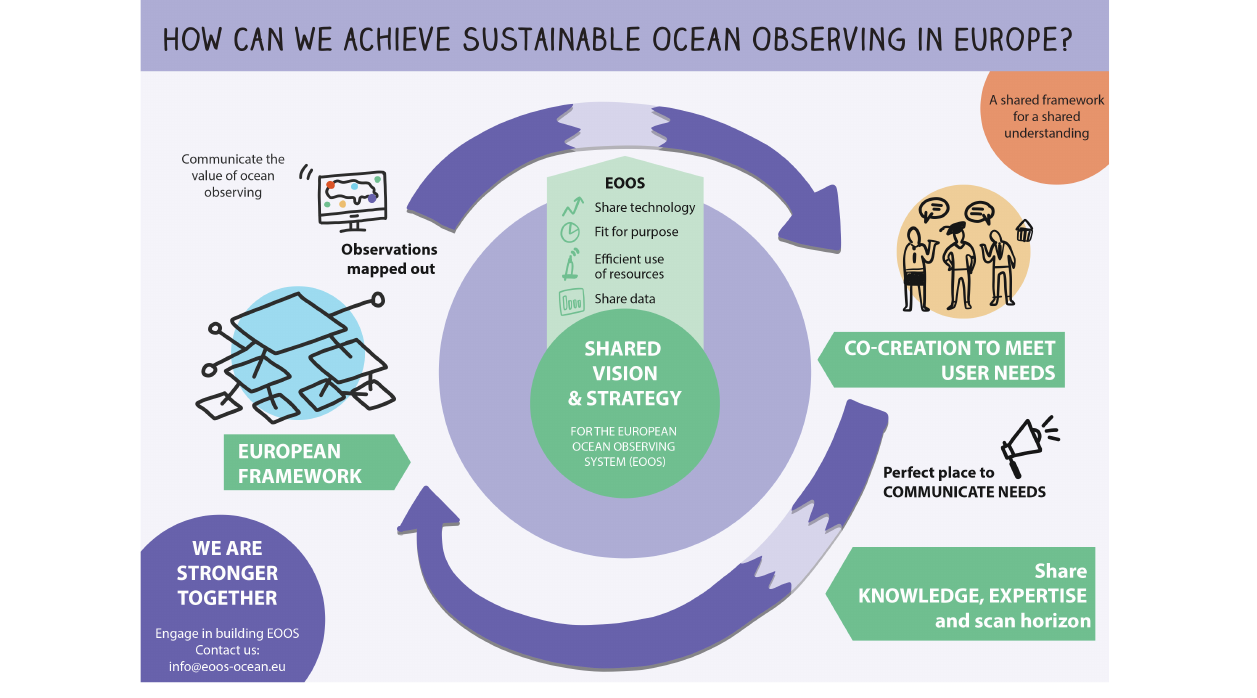
FIGURE 3 | The added value of a coordinated EOOS